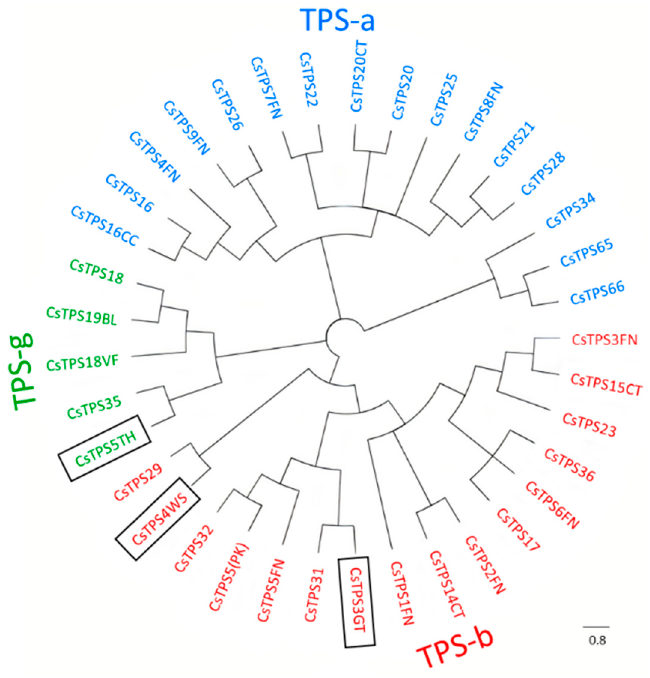
Figure 5. Phylogenetic analysis of CsTPSs. Neighbour-joining phylogenetic tree of CsTPS3GT, CsTPS4WS, and CsTPS5TH, with other CsTPSs. The scale bar indicates the number of amino acid substitutions per